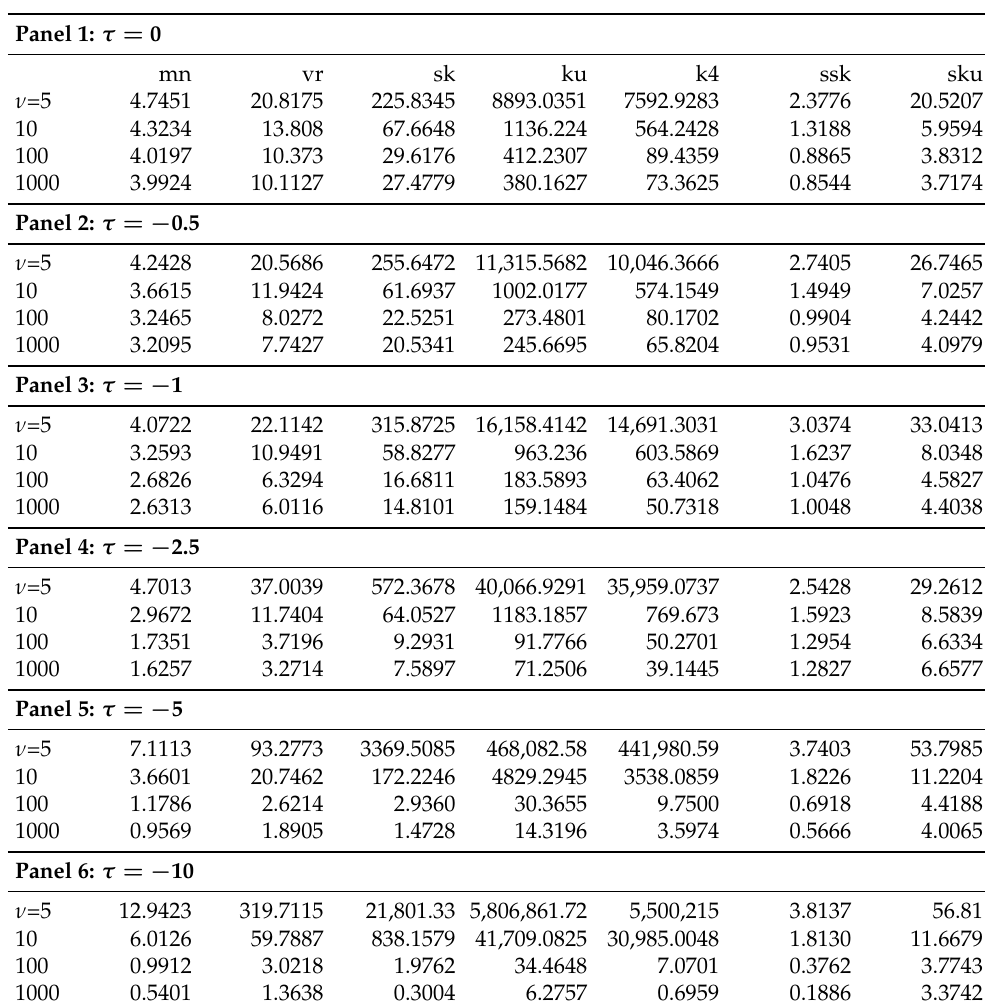
Table 8. Extended skew-Student moments, λ = 5 , τ ≤ 0